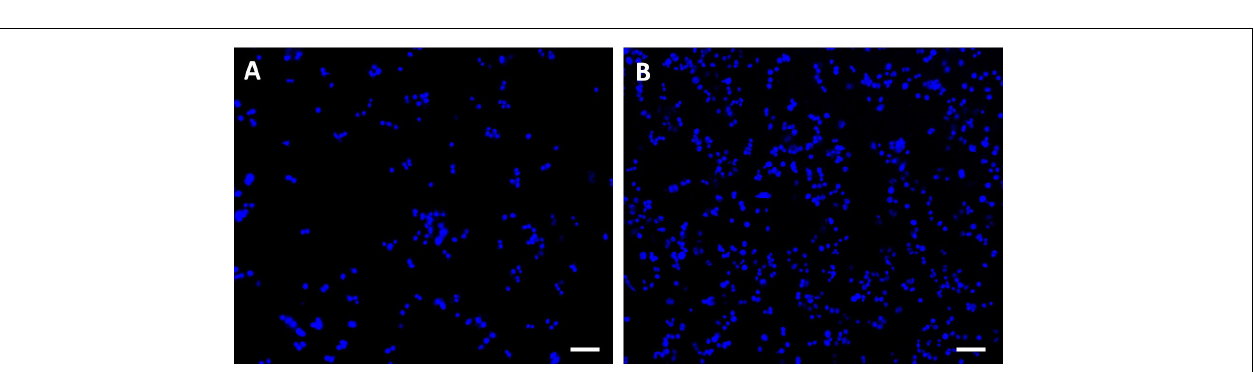
FIGURE 7 | Scanning electron microscopy images of the breast cancer cells attached on the 35% deformed stainless-steel samples. Figure in (A) shows two neighboring cells and (B) shows a single cell with higher magnification. Arrows point out the cytoplasmic protrusions. Scale bars are 3 and 1 µ m, respectively.